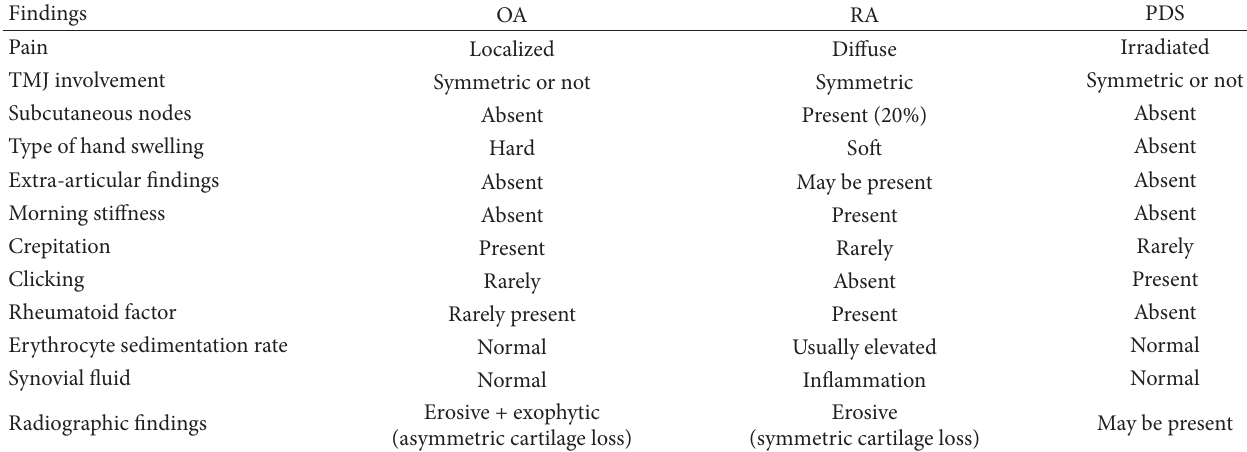
Table 1: Differential diagnosis among osteoarthritis (OA), rheumatoid arthritis (RA), and pain dysfunction syndrome (PDS) [3, 12, 13]. Findings OA RA PDS Pain Localized Diffuse Irradiated TMJ involvement Symmetric or not Symmetric Symmetric or not Subcutaneous nodes Absent Present (20%) Absent Type of hand swelling Hard Soft Absent Extra-articular findings Absent May be present Absent Morning stiffness Absent Present Absent Crepitation Present Rarely Rarely Clicking Rarely Absent Present Rheumatoid factor Rarely present Present Absent Erythrocyte sedimentation rate Normal Usually elevated Normal Synovial fluid Normal Inflammation Normal Erosive + exophytic Erosive Radiographic findings (asymmetric cartilage loss) (symmetric cartilage